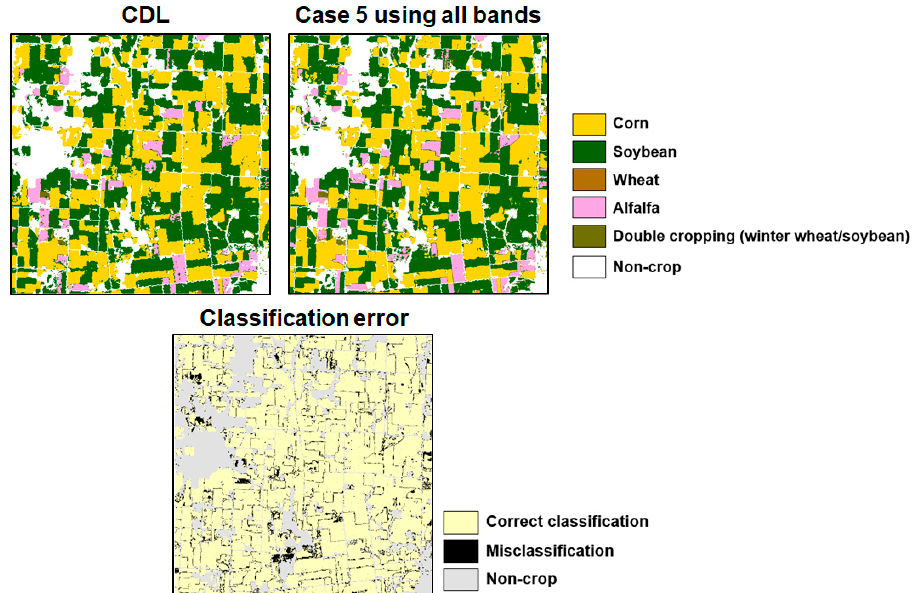
Figure 14. Comparison of the classification result of case 5 using all bands with CDL and the classi- fication error map. classification error